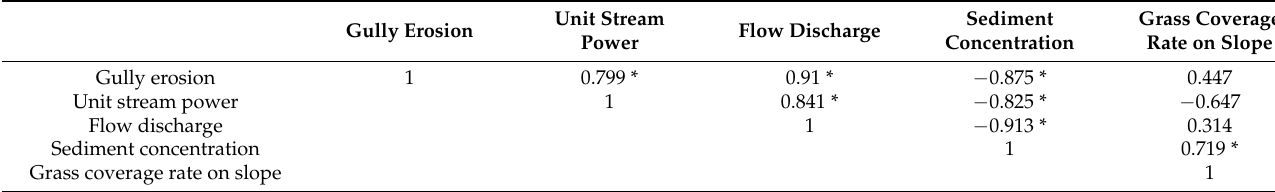
Table 5. The correlations between the gully slope erosion and effect factors. Unit Stream Sediment Grass Coverage Gully Erosion Flow Discharge Power Concentration Rate on Slope Gully erosion 1 0.799 * 0.91 * − 0.875